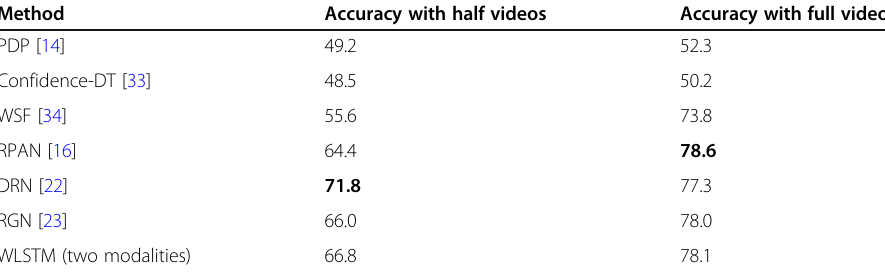
Table 7 Prediction accuracy comparison on sub-JHMDB (%)